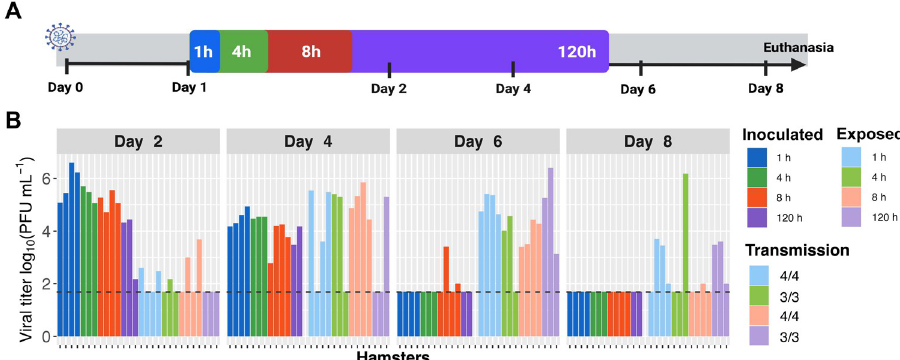
Fig 1. Exposure durations as short as 1 h are sufficient for robust SARS-CoV-2 transmission. A] Schematic depicting experimental timeline. Animals were inoculated with 1x10 4 PFU [titered on VeroE6 cells] at Day 0 and exposures initiated at Day 1. Colored boxes show the different exposure periods, with the duration indicated within each box. B] Viral titers in nasal lavage samples collected from inoculated [dark colors] and exposed [light colors] hamsters are plotted. Facets show results from 2-, 4-, 6- and 8-days post-inoculation [dpi] with different colors indicating the duration of exposure [1, 4, 8 or 120 h]. Exposures were carried out at 30˚C and 50% RH. Horizontal dashed line indicates limit of detection [50 PFU]. Missing data indicate that the animal died or was euthanized mid- way through the experiment. The fraction of transmission pairs in which recipients shed infectious virus at one or more time points is indicated at the